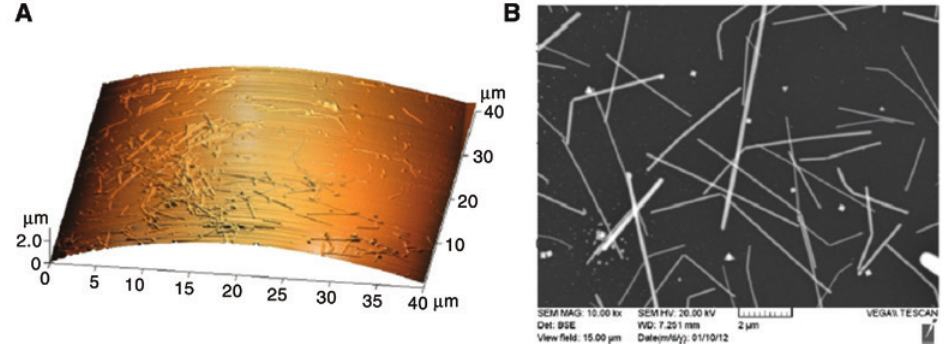
Figure 5: AFM (A) and SEM (B) images of the fiber surface coated with silver nanowires. Figures adapted with permission from Ref. [40]. Copyright (2012) IOP Publishing.